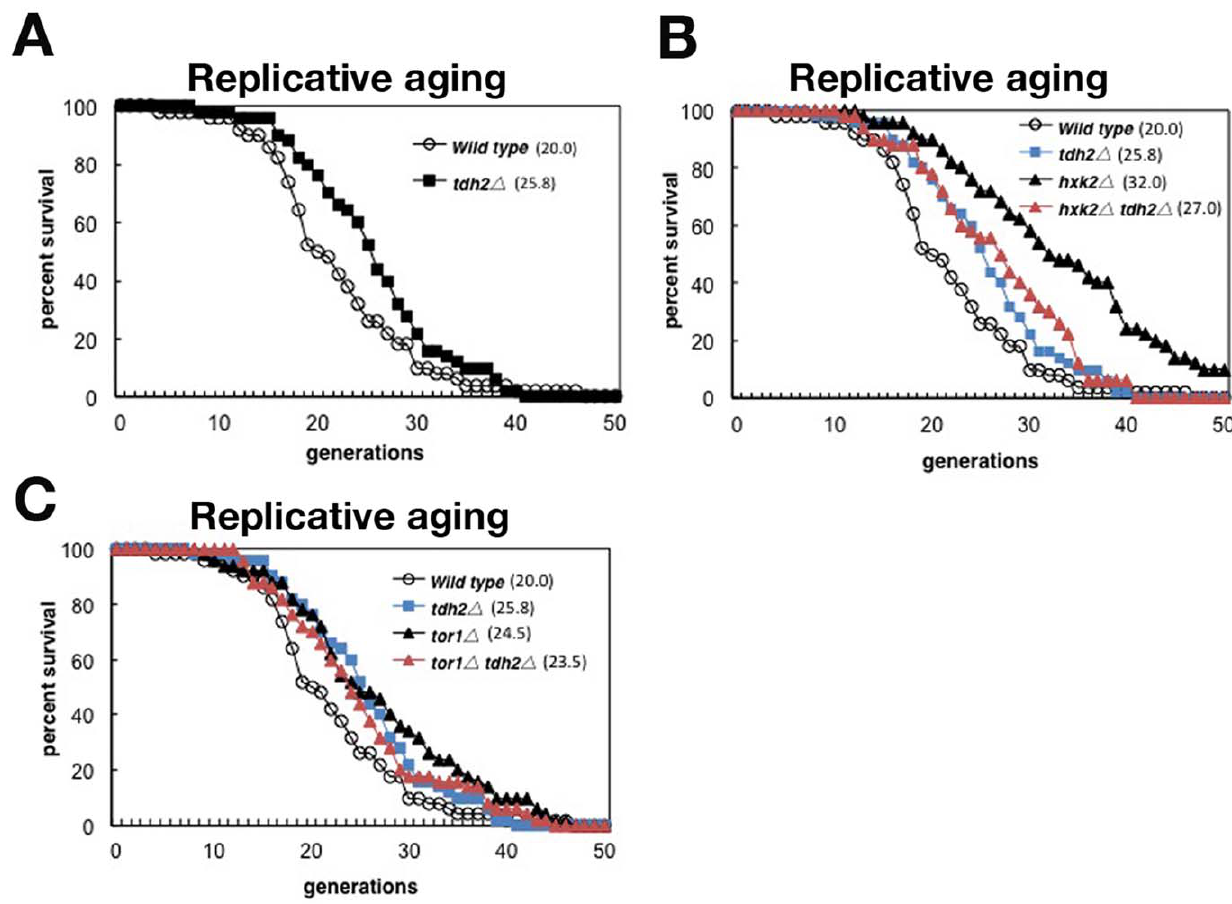
Figure 5. TDH2 gene deletion extends the RLS in a manner similar to that of the CR pathway. ( A ) The RLSs of wild type and tdh2 D cells. ( B ) The RLSs of wild type, tdh2 D , hxk2 D and hxk2 D tdh2 D cells. ( C ) The RLSs of wild type, tdh2 D , tor1 D and tor1 D tdh2 D cells. The difference between strains was performed on statistical calculations (Fig. S1).